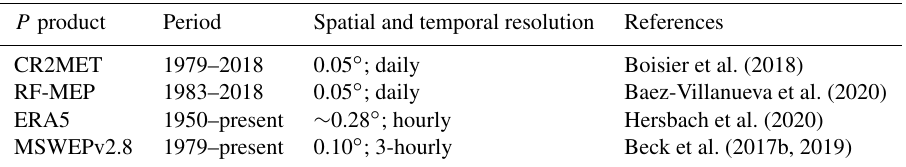
Table 2. Gridded P products used in this